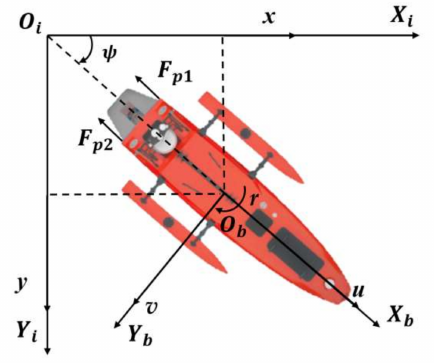
Figure 16. The motion coordinates of “M80”